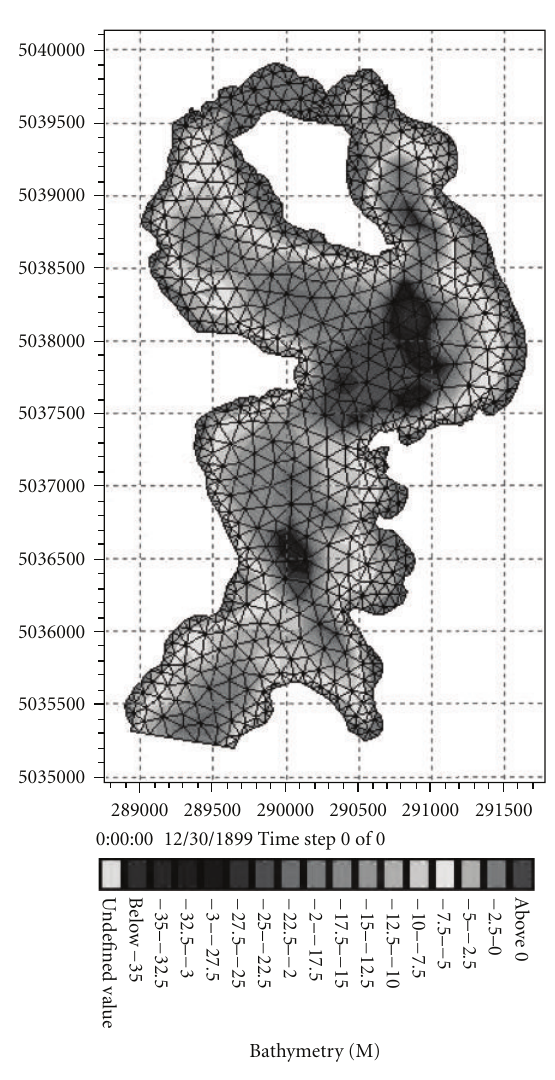
Figure 3: The numerical modeling mesh and depth map